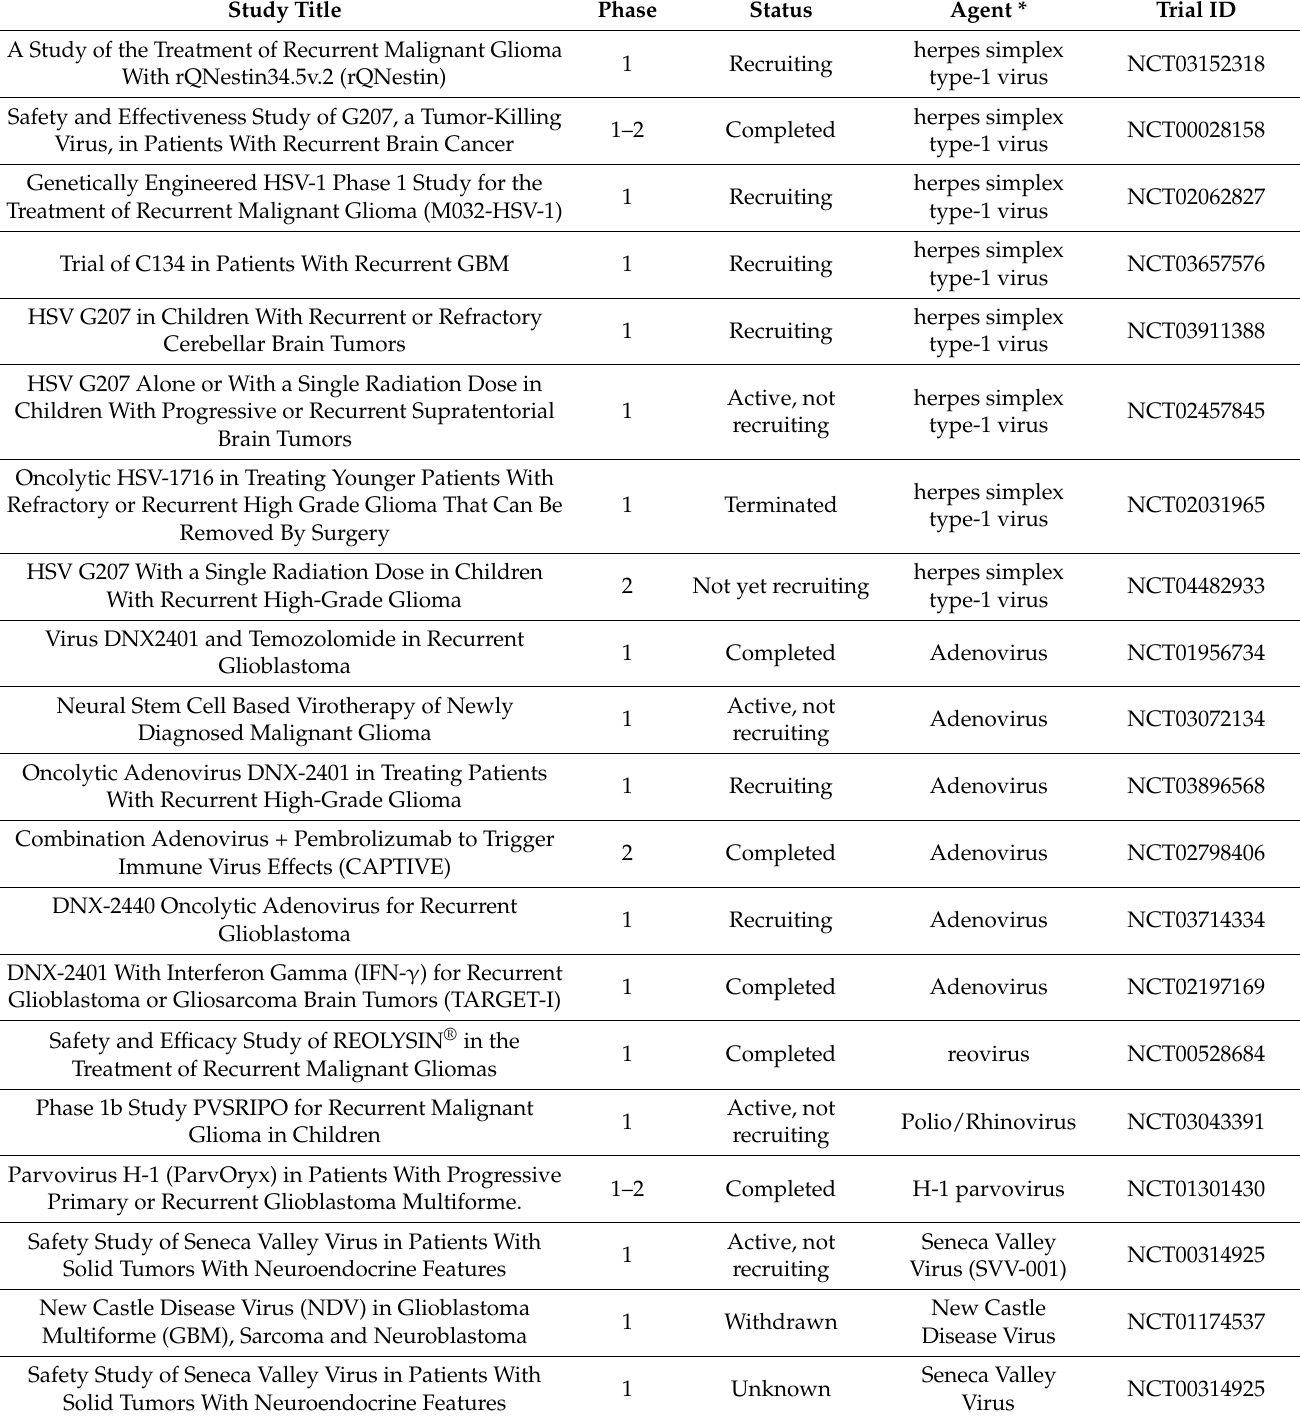
Table 1. List of registered clinical trials that use viral agents (alone or in combination with standard therapy) against